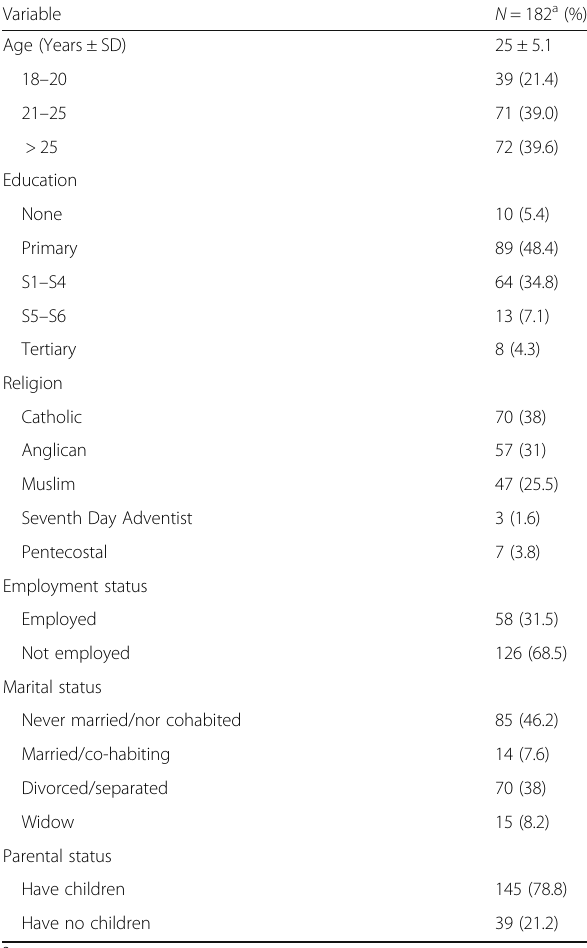
Table 1 Characteristics of the female sex workers who participated in the